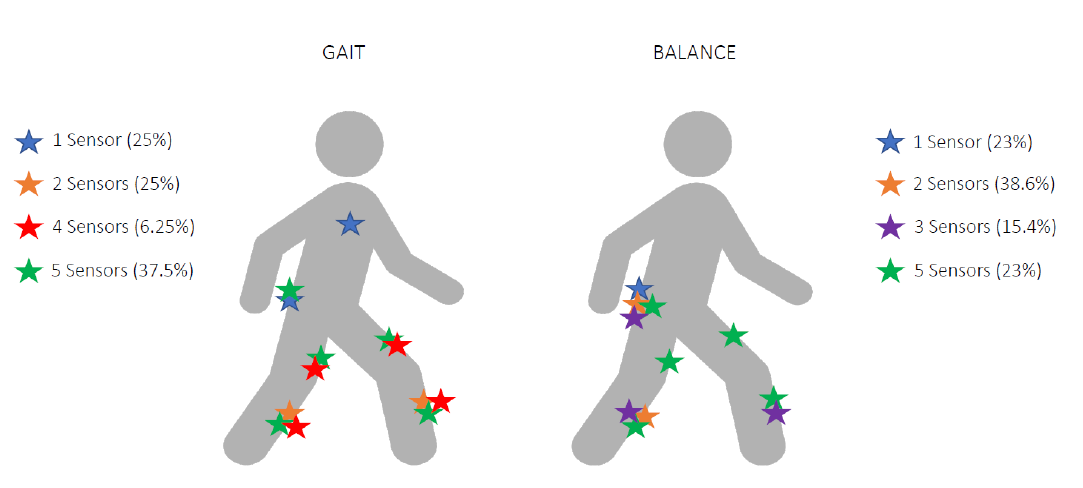
Figure 3. Anatomical representation of sensor placement for gait and balance assessment in patients with polyneuropathy (PNP).